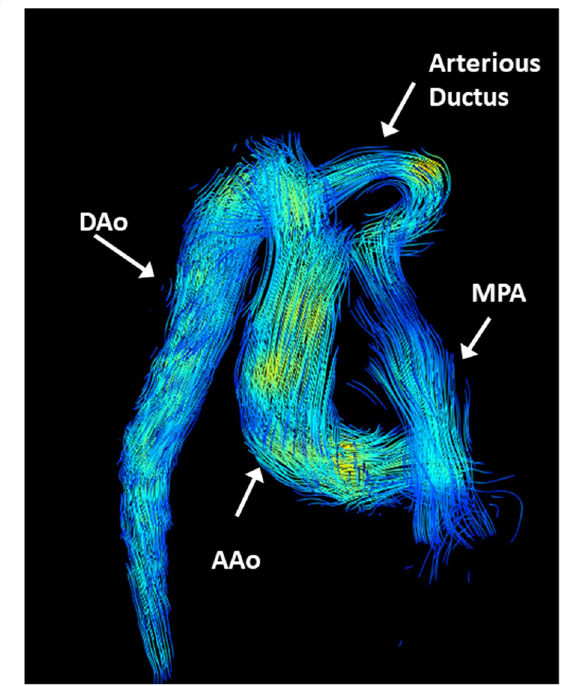
Fig. 20 (4D flow MRI): characterization of flow dynamics of the great thoracic vessels (oblique antero-lateral view) in a healthy preterm fetus. Blood flow direction and velocity are indicated by velocity-coded streamlines (DAo descending aorta, AAo ascending aorta, MPA main pulmonary artery, ductus arteriosus). The advent of 4D techniques simplified the demonstration and understanding of even complex vascular